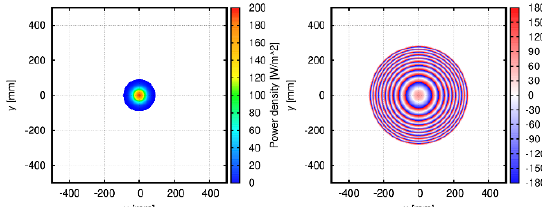
Fig. 5. Field of the beam U1 after the mirror M2 in the upper launcher.